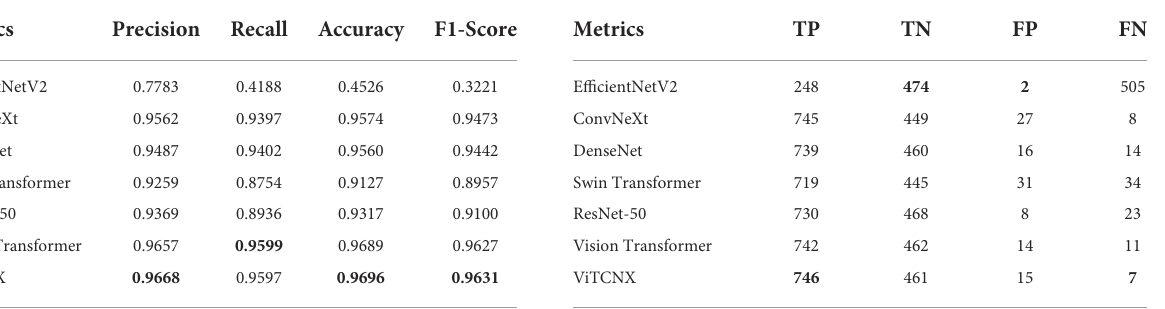
TABLE 2 Performance of ViTCNX and the other six models under three classification.